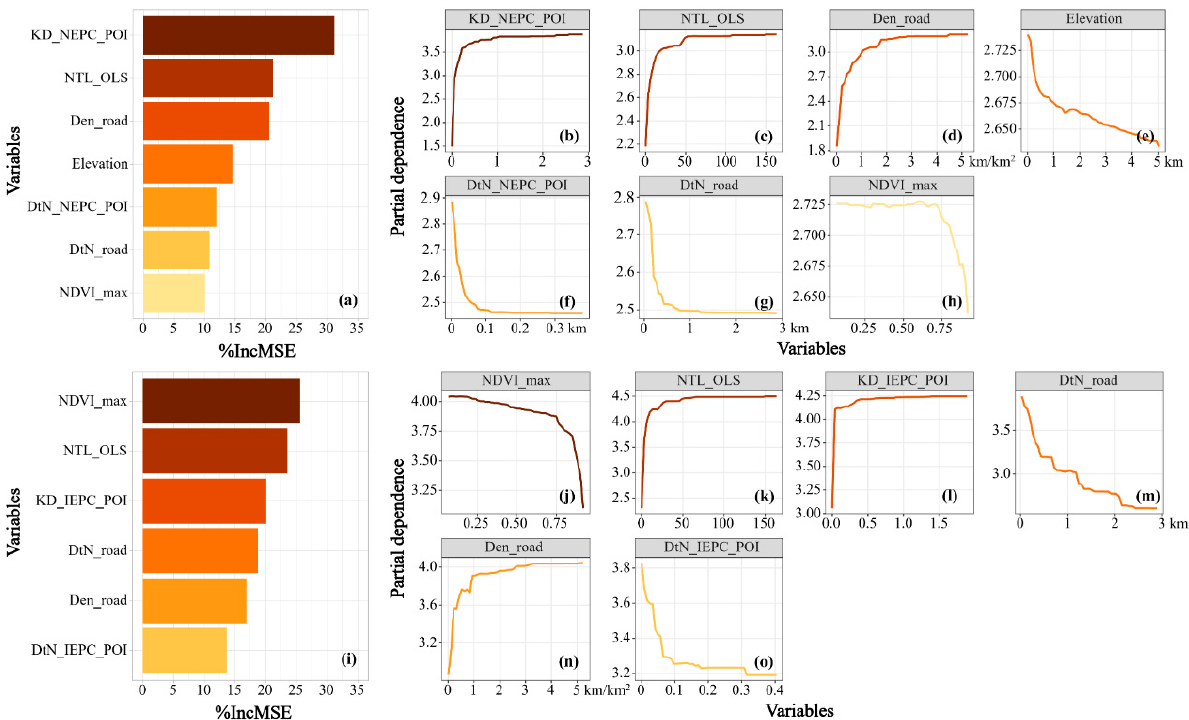
Figure 7. Importance of each explanatory variable and the partial dependence of EPC estimation on each explanatory variable via the RF model: ( a – h ) NEPC model; ( i – o ) IEPC model.